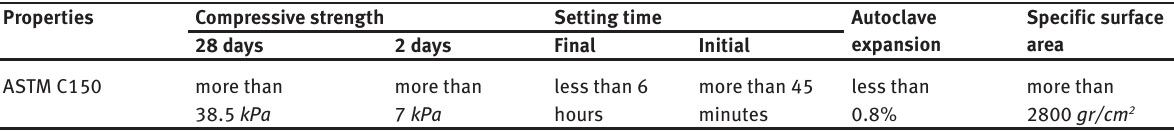
Table 3: Physical properties of cement.